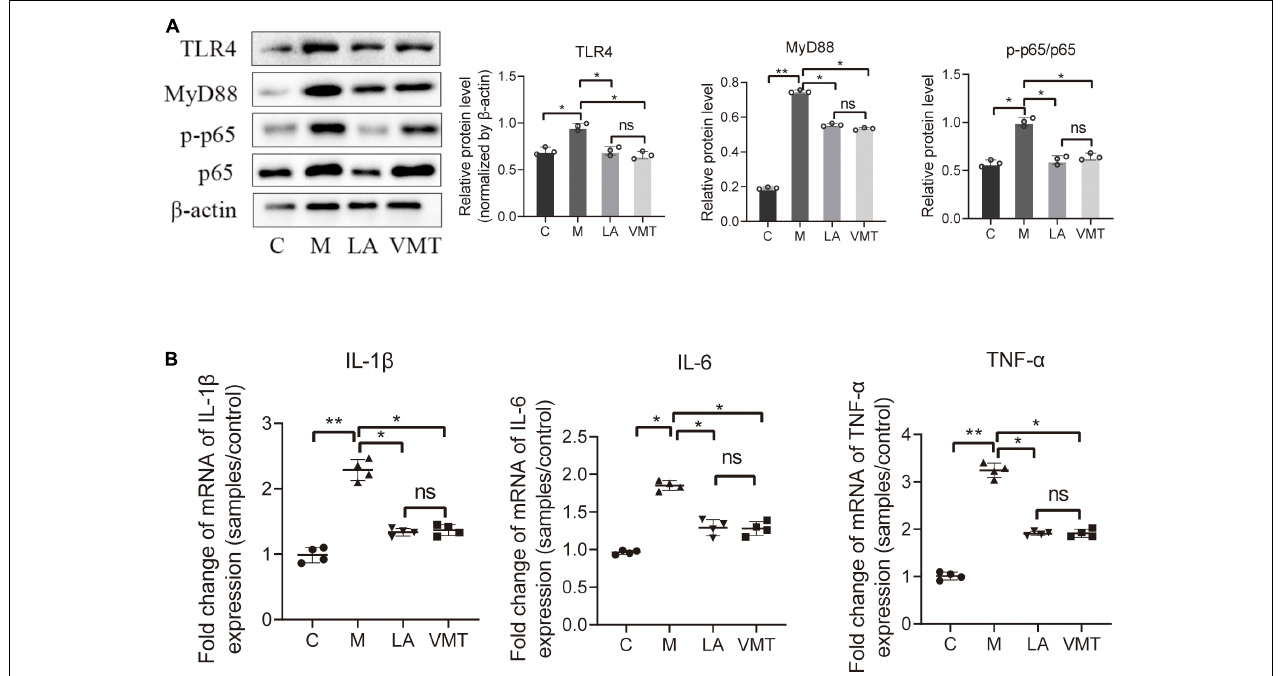
FIGURE 7 | VMT inhibit inflammatory cytokines and key proteins of the NF- κ B signaling pathway. (A) qPCR-based relative expression of IL-1 β , TNF- α , and IL-6 levels in peritoneal fluid from the indicated treatment groups. Data are presented as mean ± SE ( n = 4). (B) Western blot analysis of TLR4, MyD88, p65, and p-p65 expression in ectopic lesions, β -actin was used as an internal control ( n = 3). The relative expressions of TLR4, MyD88, p65, and p-p65 were quantified by ImageJ. Data are presented as means ± SD. One-way repeated-measures ANOVA with Tukey’s test for multiple comparisons, * p < 0.05, ** p < 0.01, and ns,